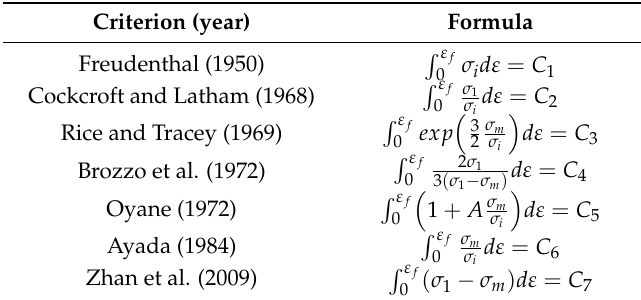
Table 1. Selected ductile fracture criteria used in the analysis